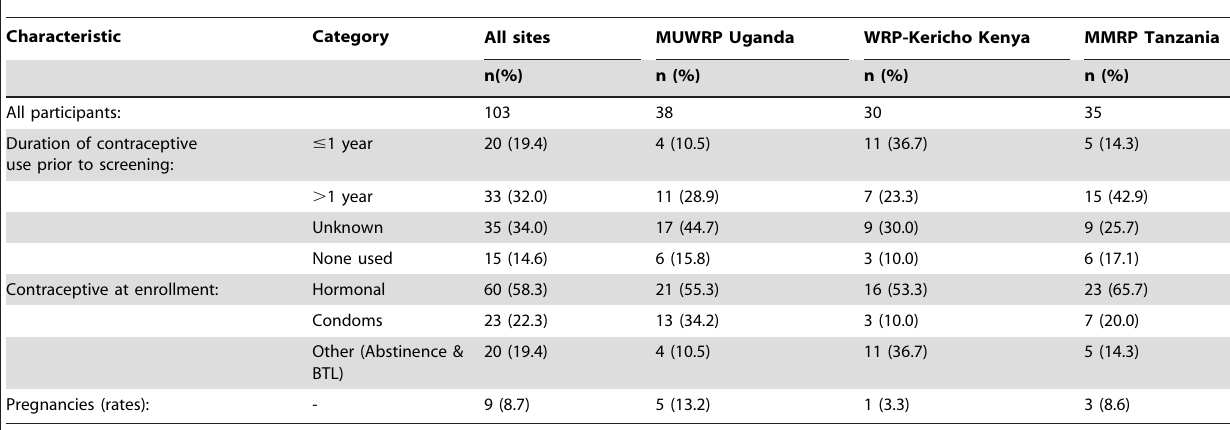
Table 2. Duration of Contraceptive use prior to Screening, Contraceptive Methods Used at enrollment and Pregnancies Reported